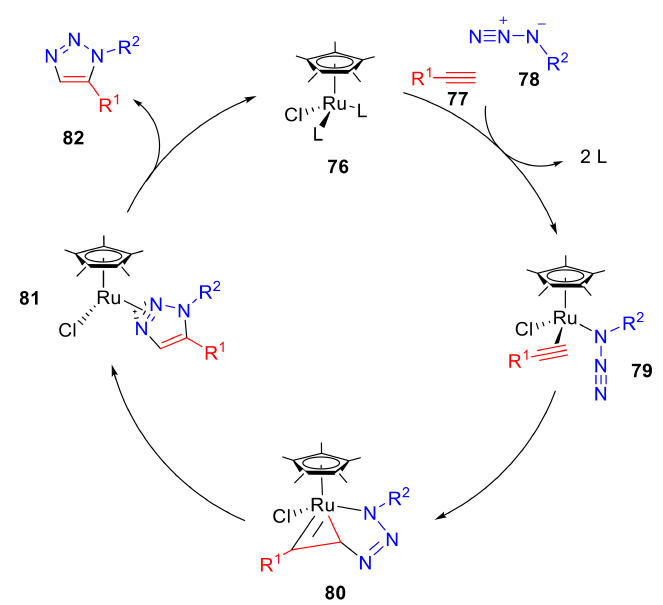
Scheme 25. Catalytic cycle of RuAAC proposed by Boren and